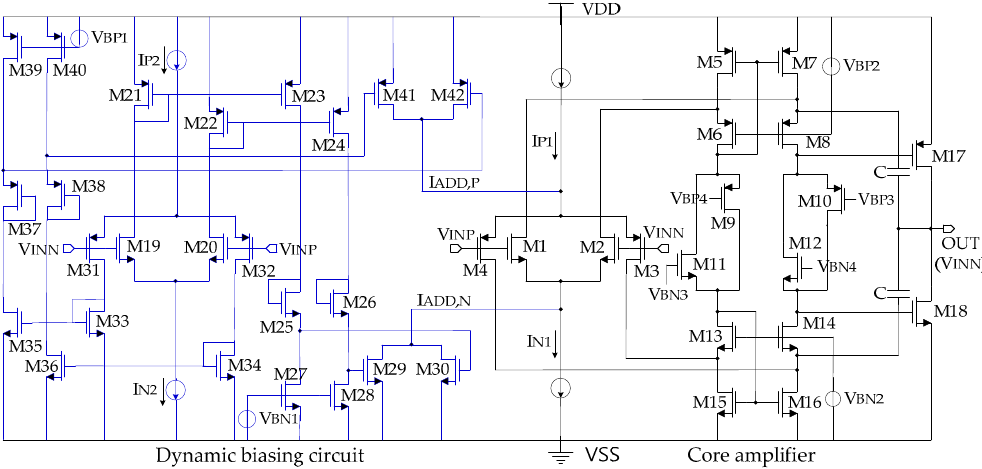
Figure 1. Conventional bu ff er amplifier with slew rate enhancement for an entire rail-to-rail input and output signal range [19].